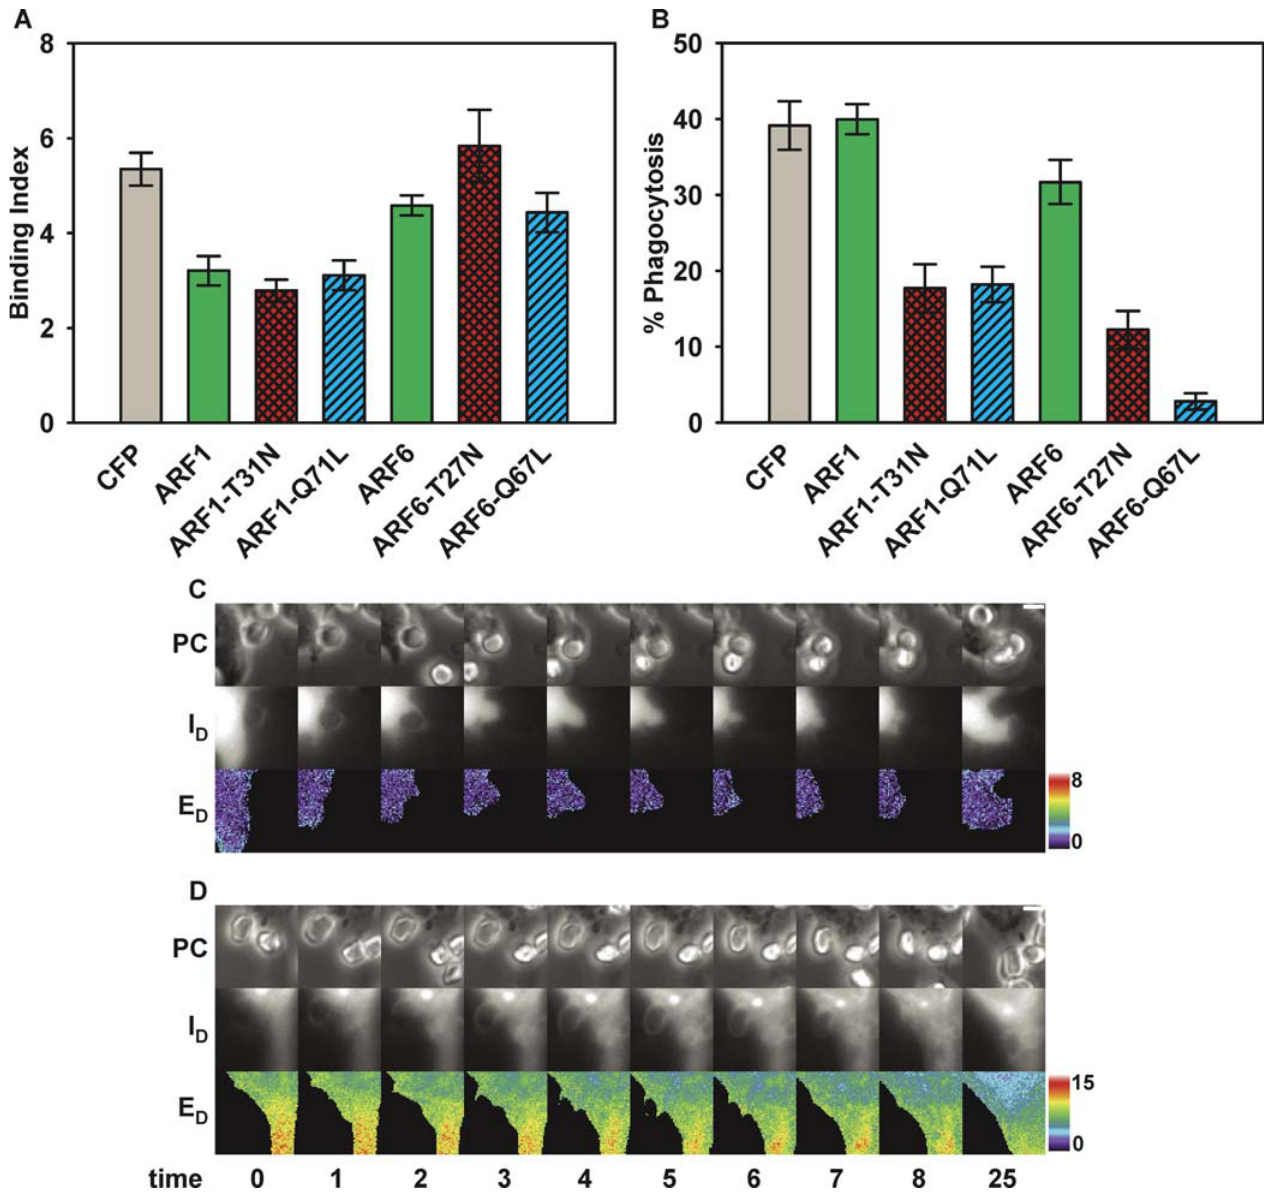
Figure 5. Effect of ARF1 and ARF6 Cycling Mutants on the Phagocytic Efficiciency of Macrophages and Imaging of ARF1(T31N)- and ARF1(Q71L)- Arrested Phagosomes (A) The effects of expression of the ARF-CFP chimeras on the binding of opsonized target particles. The ARF1-CFP chimeras generally reduced the binding index of macrophages, while the ARF6-CFP chimeras did not affect target particle binding. (B) Phagocytic indexes were measured for macrophages expressing CFP fusions of ARF1, ARF1(T31N), ARF1(Q71L), ARF6, ARF6(T27N), or ARF6(Q67L). The number of internalized and bound, uninternalized erythrocytes were counted for macrophages expressing the various constructs. Although ARF1- CFP did not reduce phagocytosis, expression of ARF1(T31N)-CFP or ARF1(Q71L)-CFP led to a reduction in phagocytic efficiency. Similarly, ARF6-CFP, in its wild-type form, produced a small inhibition of phagocytosis, but the constitutively activated and dominant-negative forms of ARF6-CFP impaired phagocytosis to a much greater degree. For all constructs except ARF6(Q67L)-CFP, results are the average of at least two experiments in which three coverslips were assayed. At least 25 macrophages were counted per coverslip. The ARF6(Q67L)-CFP results are from 31 macrophages counted on six coverslips. The error bars in (A) and (B) represent 6 SEM. (C and D) Time-lapse fluorescence microscopy from macrophages expressing YFP-NGAT and ARF1(T31N)-CFP or ARF1(Q71L)-CFP. Note that the last image in the series was taken 25 min after the initiation of phagocytosis. Control RAW264.7 macrophages typically required 6–8 min to complete phagocytosis from the onset of pseudopod extension. The scale bars in the far-right phase contrast panels are 3 l m. (C) In macrophages expressing ARF1(T31N)-CFP, phagocytic cups formed, but the macrophages failed to close the phagosome. (D) Expression of ARF1(Q71L)-CFP also prevented phagosome closure. The phagocytic cup is visible in the fluorescence image. DOI: 10.1371/journal.pbio.0040162.g005